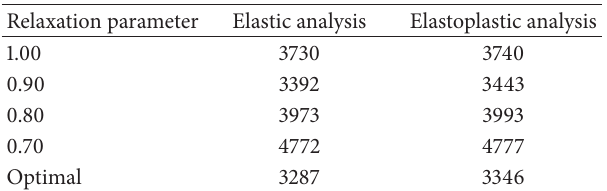
Table 2: Total number of iterations (considering all time steps) for the dynamic